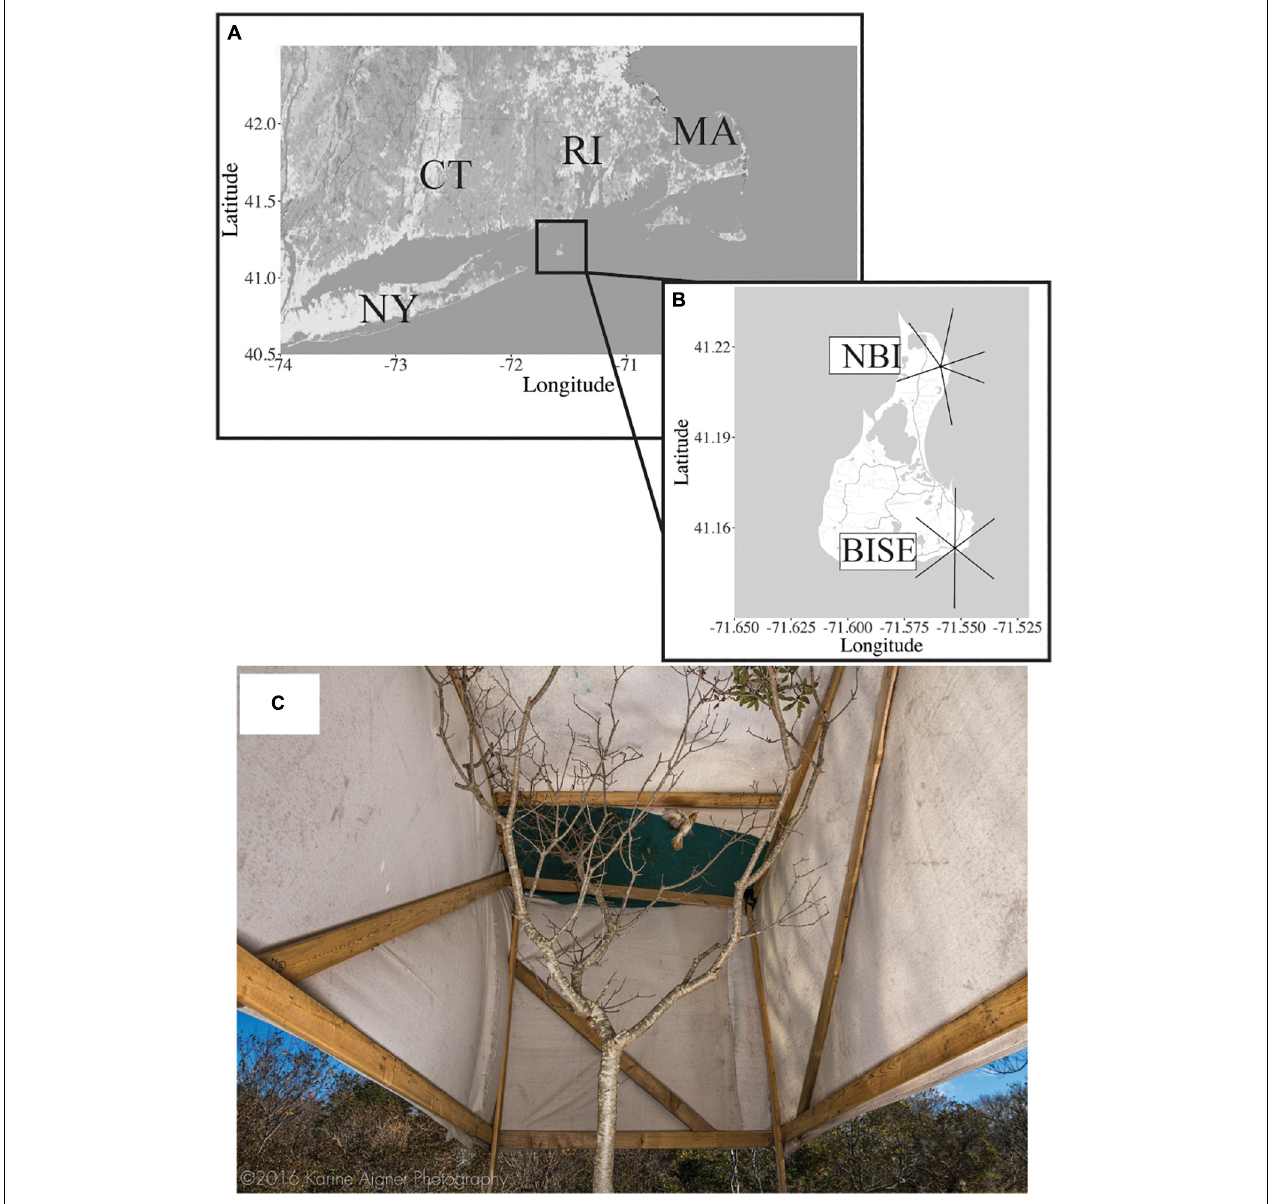
FIGURE 1 | (A) Location of Block Island (41 ◦ 130N, 71 ◦ 330W), Rhode Island, United States with (B) the antennas of the two automated radio telemetry towers marked (NBI: northern Block Island and BISE: southeast Block Island). (C) Picture from the ground of a Hermit Thrush in the soft-release aviary that is entirely covered in canvas except for the bottom 1 m which was left open. Note that this was a re-enactment photo taken during the mid-day; in reality, birds were gently placed in this aviary 1.5–2.5 h after sunset and then were allowed to voluntarily depart, usually at dawn the next day (see section “Materials and Methods” for details). Photo by